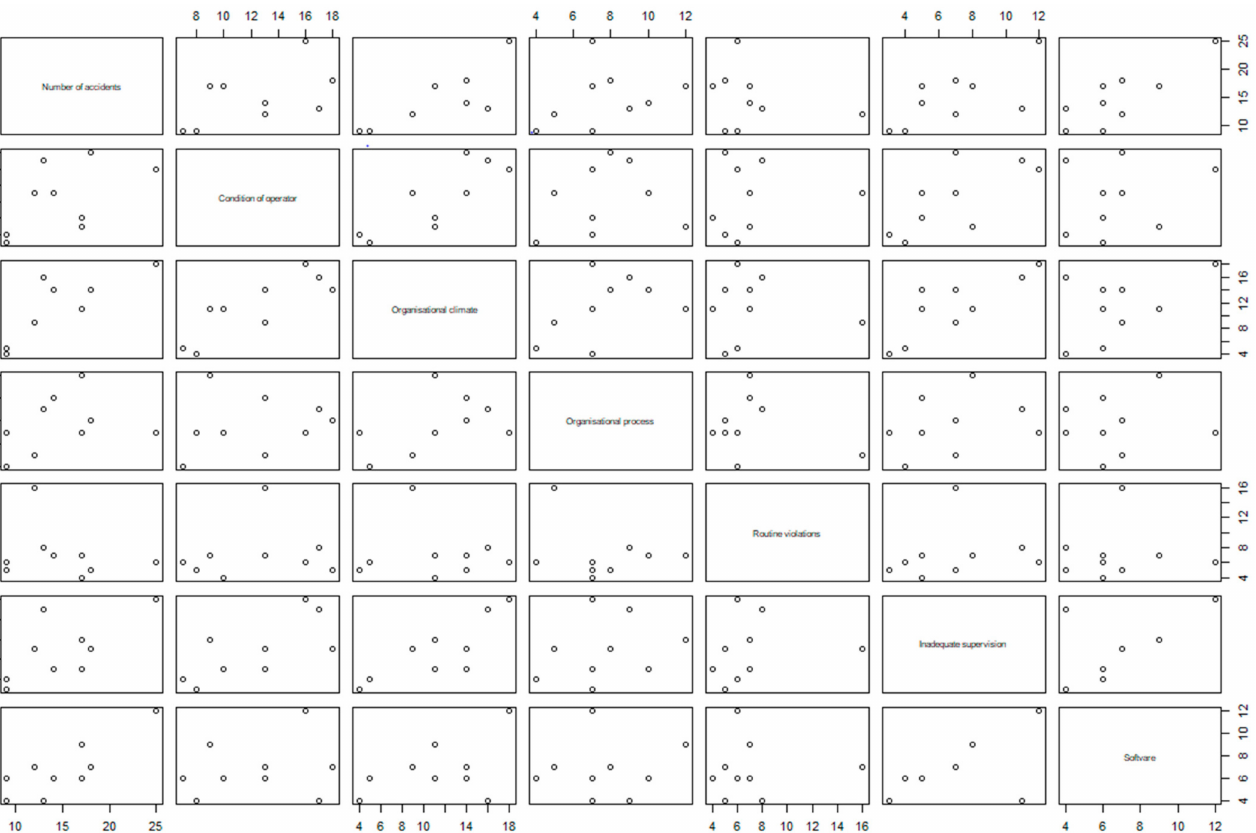
Figure 2. Scatterplot diagram matrix of explanatory